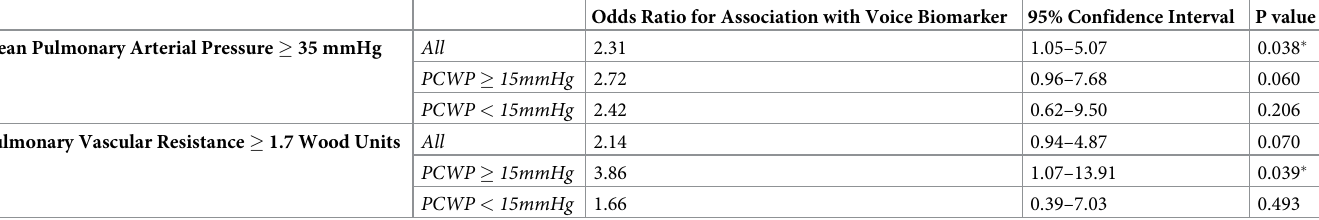
Table 3. Multivariable analyses evaluating the association between mean voice biomarker and hemodynamic indices measured at invasive hemodynamic study. Odds Ratio for Association with Voice Biomarker 95% Confidence Interval P